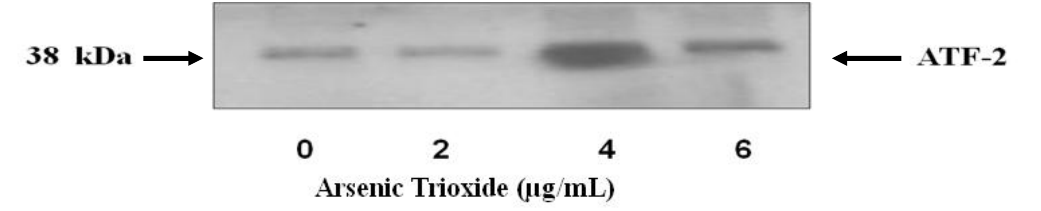
Figure 3a. Effect of arsenic trioxide on p38 MAPK expression in A549 cells.